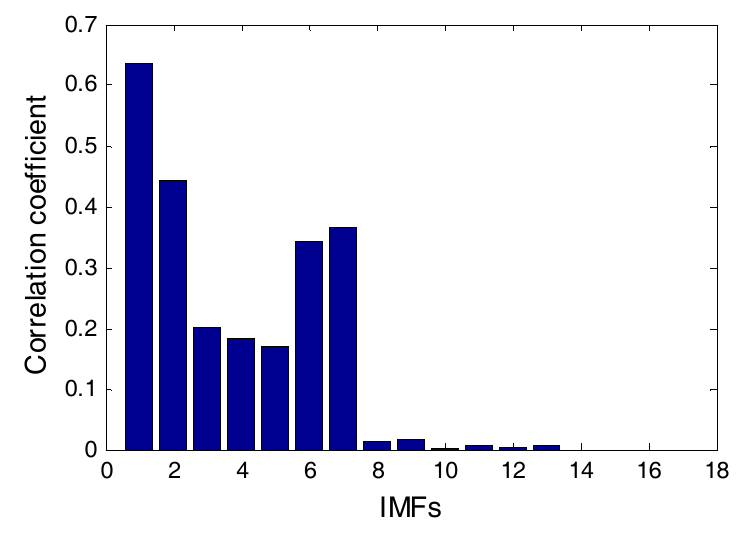
Figure 13. The IMFs decomposed by EMD.